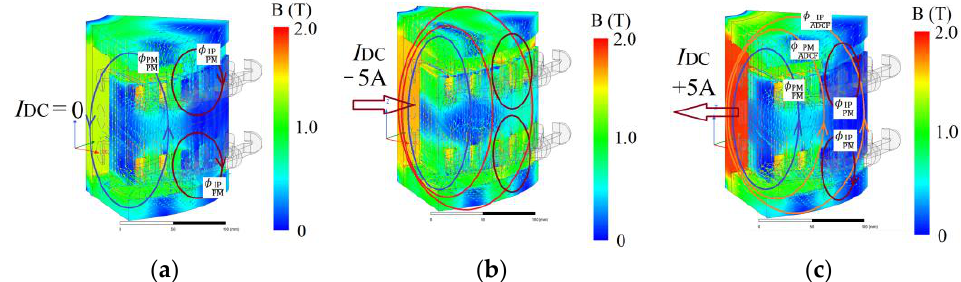
Figure 3. Idealized magnetic flux distribution in FCAFPMM at DC coil current I DC = 0 ( a ), I DC − 5 A ( b ) and I DC +5 A ( c ).